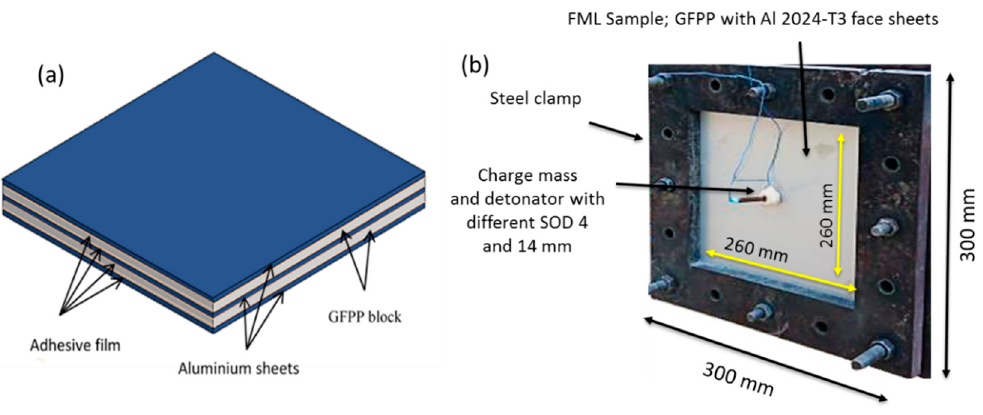
Figure 2. ( a ) The schematic showing the lay-up configuration, ( b ) dimension of the exposed area for a fibre metal laminates (FML) sample.